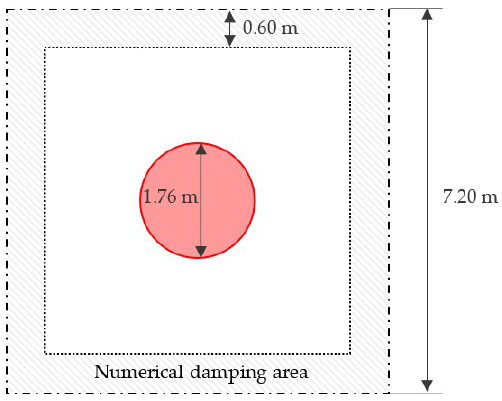
Figure 4. Top view of the numerical tank for the radiation test.